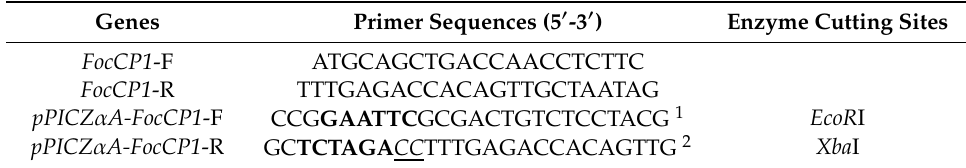
1 Bold letters: restriction enzyme cutting sites, 2 Italicized and underlined letters: frame-shifted